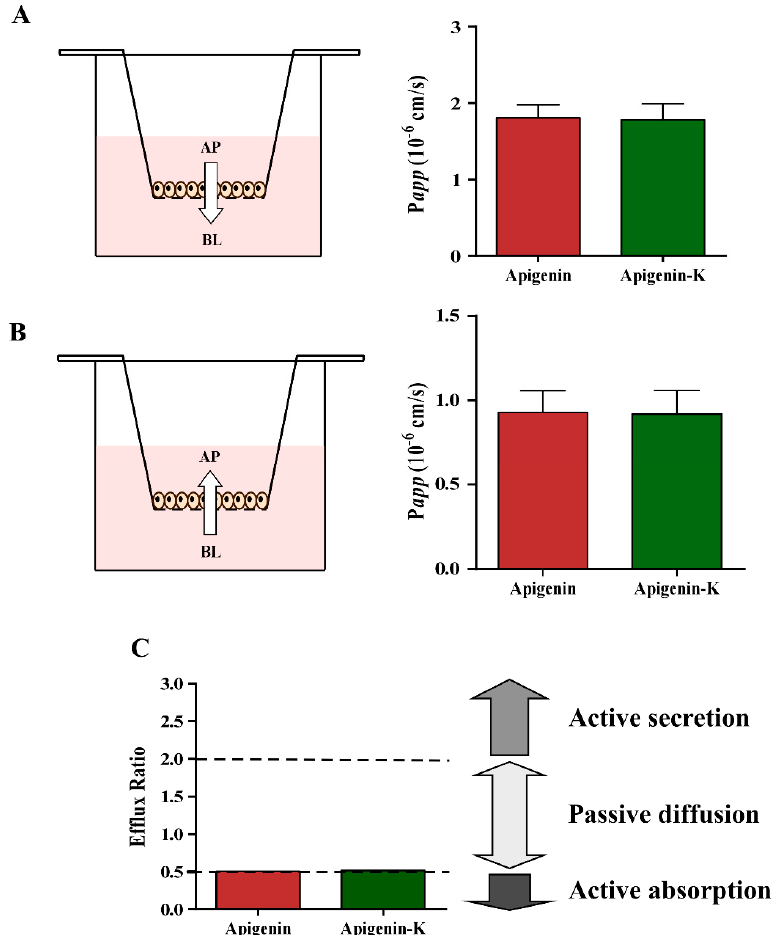
Figure 3. P app values and diagram of permeation flow for both apigenins in AP-BL ( A ) and BL-AP ( B ) directions respectively. ( C ) Efflux ratio plot for both apigenins, showing the different transport mechanism categories.